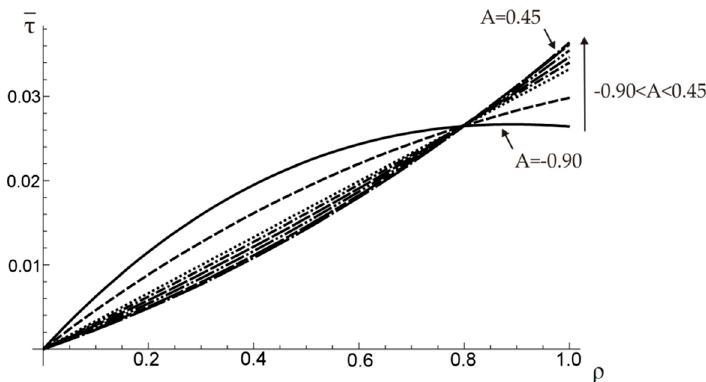
Figure 8. The distribution of shearing stress τ = τ / τ M